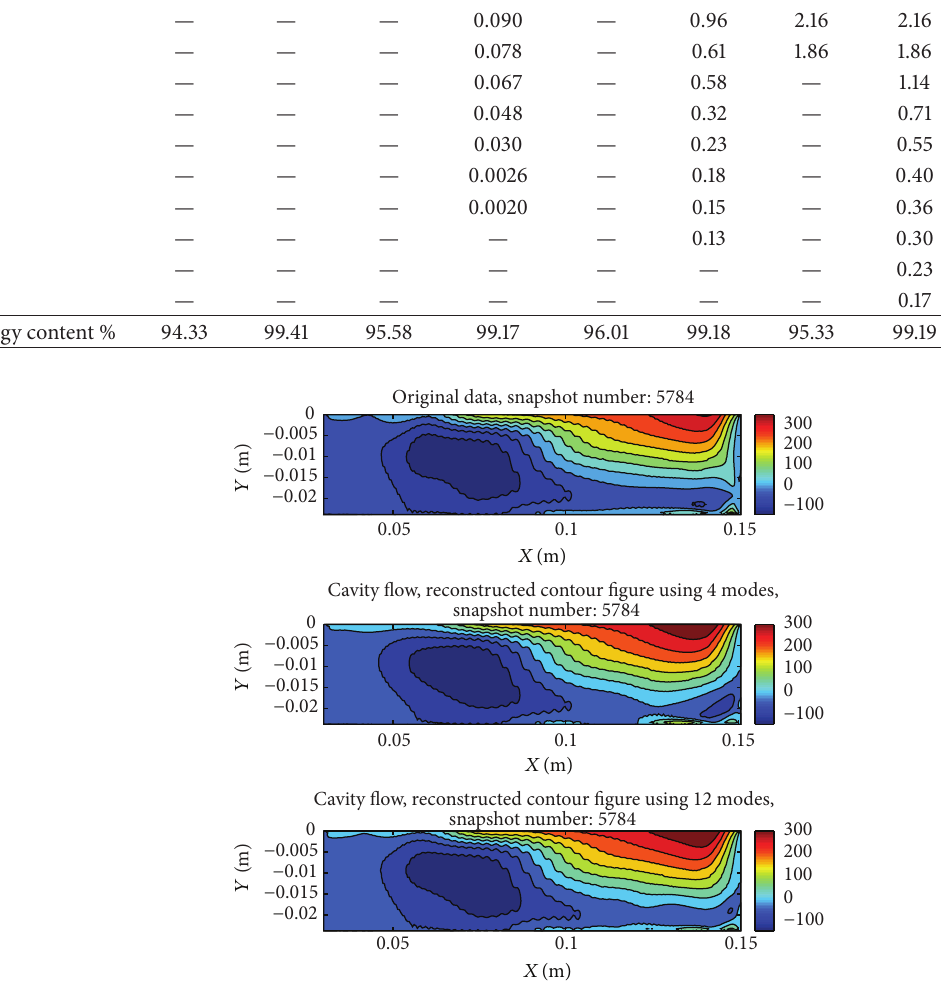
Figure 11:Original 𝑥 -velocity contour and reconstructed 𝑥 -velocity